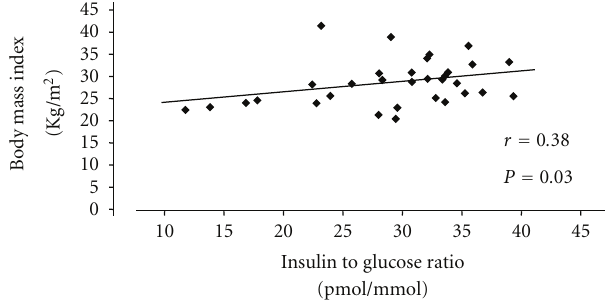
Figure 1: Relationship between body mass and insulin resistance in patients with polycystic ovary syndrome.There is a significantly positive correlation between body mass index and insulin to glucose ratio. Modified from Moran et al.